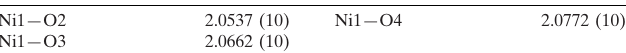
Selected bond lengths (A ˚ ).